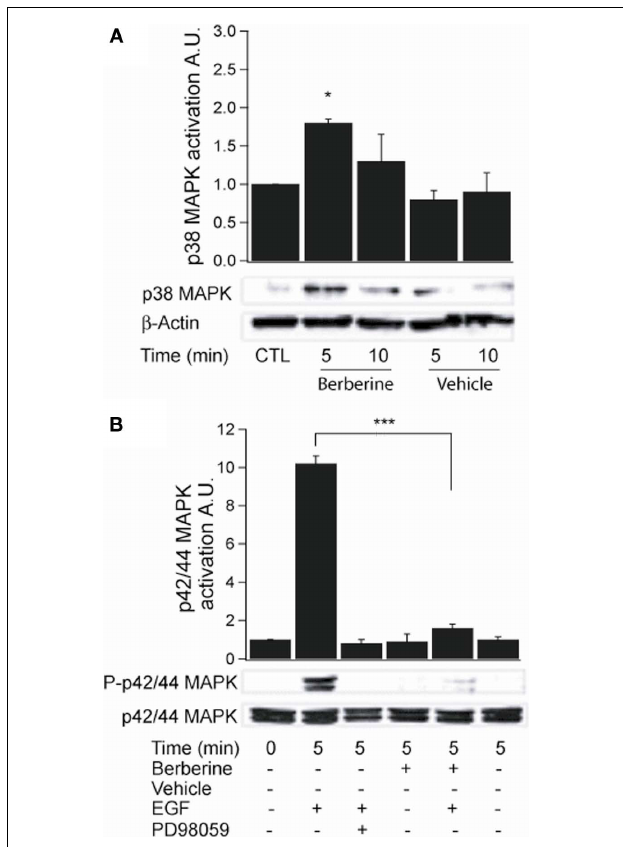
FIGURE 5 | Berberine effect on MAPK signaling inT84 cells. (A) Representative blot of p38 MAPK phosphorylation levels atThr 180 /Tyr 182 in cellular extracts fromT84 cells after berberine treatment (300 μ M) for 5 and 10min compared to vehicle controls. (B) Representative blot of p42/p44 MAPK phosphorylation levels atThr 202 /Tyr 204 in cellular extracts fromT84 cells after berberine treatment (300 μ M) for 5 and 10min compared to vehicle controls.T84 cells were treated with EGF (100ng · ml − 1 ) for 5min to stimulate p42/p44 MAPK phosphorylation. PD98059 (20 μ M) was added 15min prior EGF-treatment. B-actin was used as an internal control for protein loading.The graphs represent densitometric analysis of blots. Values are given as fold changes in MAPK phosphorylation (activation) respect to an untreated control.Values are displayed as mean ± SEM ( n = 3 for each group, * P < 0.05, *** P < 0.001).